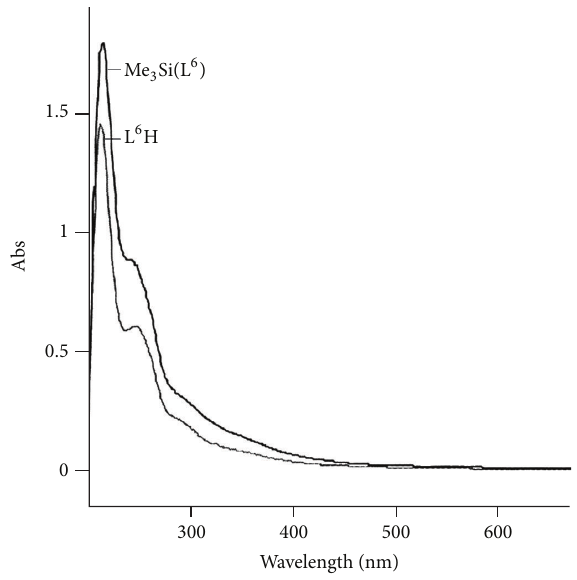
Figure 1: Electronic Spectra of Ligand (L 6 H) and their Silicon